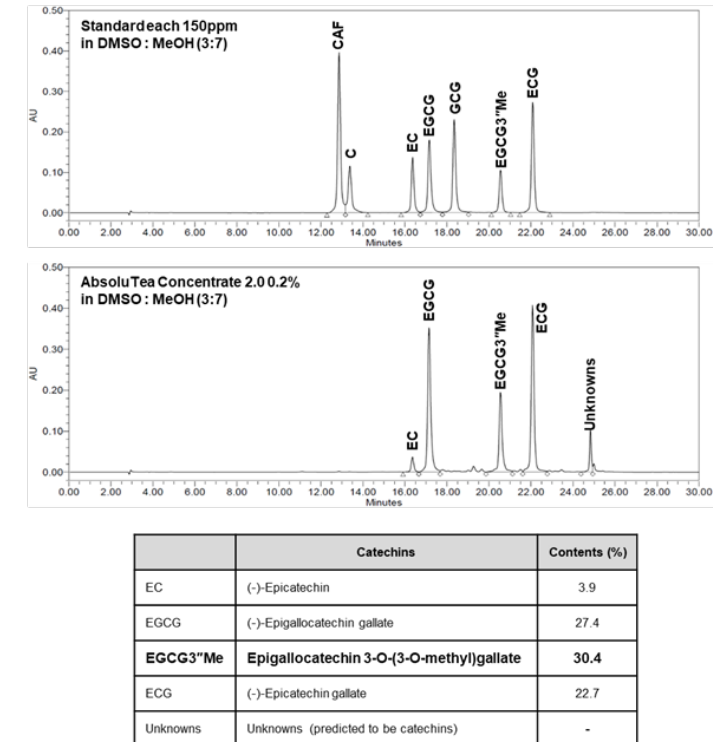
Figure 1. Structure of 3”Me-EGCG ( A ) and profile ( B ) of AbsoluTea Concentrate